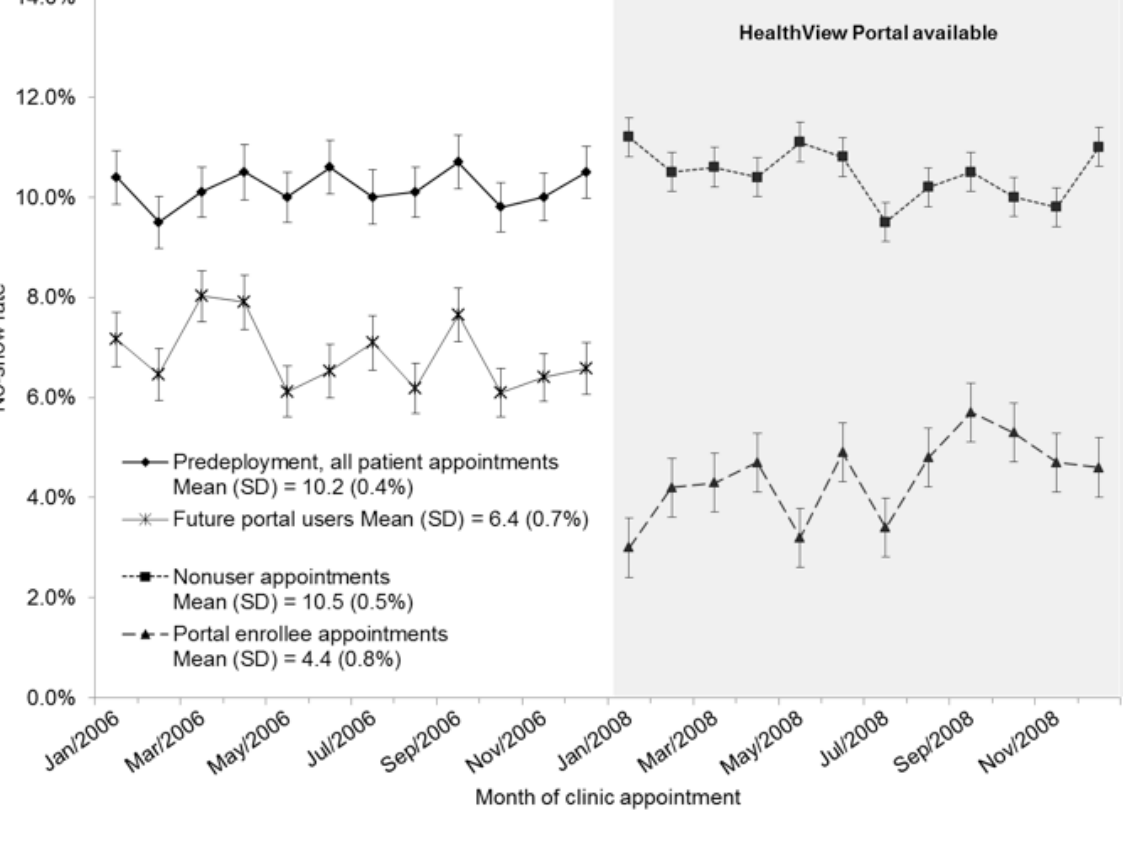
Figure 2. Monthly appointment no-show rates over time for seven DUHS